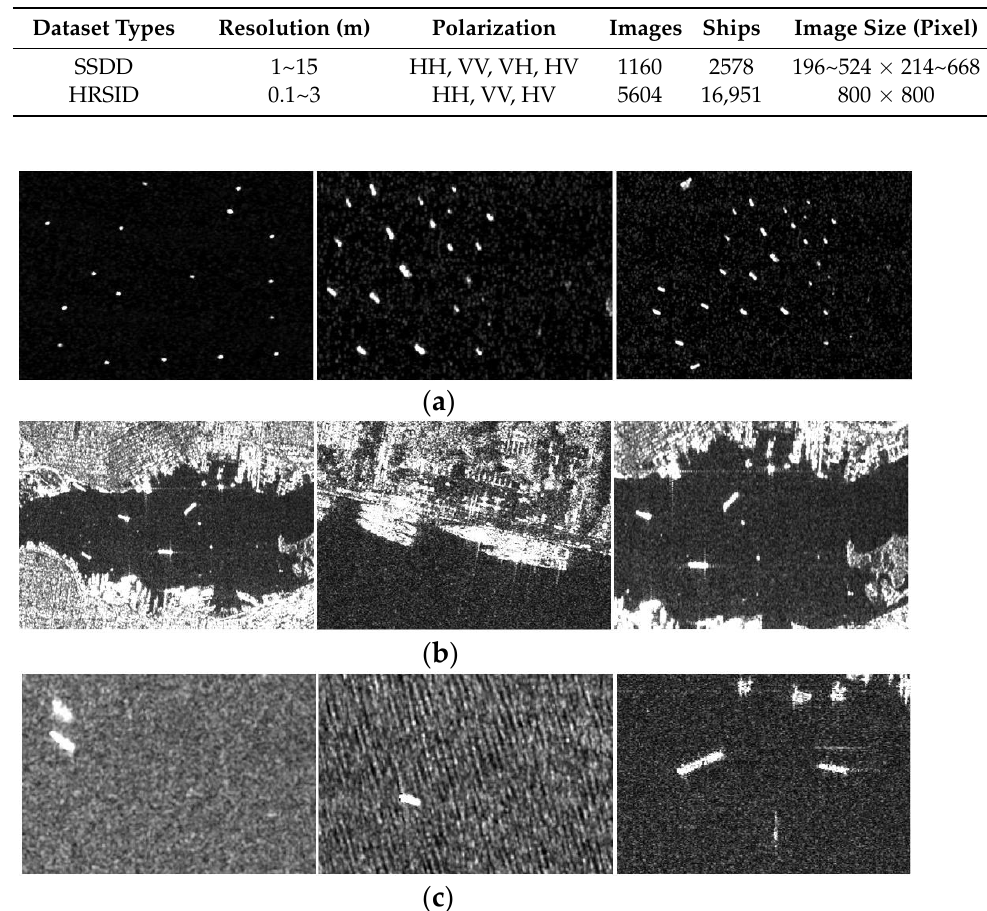
Figure 10. Ships in different situations in SSDD: ( a ) Small ships in SAR images; ( b ) Near-shore ships in SAR images; ( c ) Ships affected by high noise in SAR images. Table 1. Detail of SSDD and HRSID.